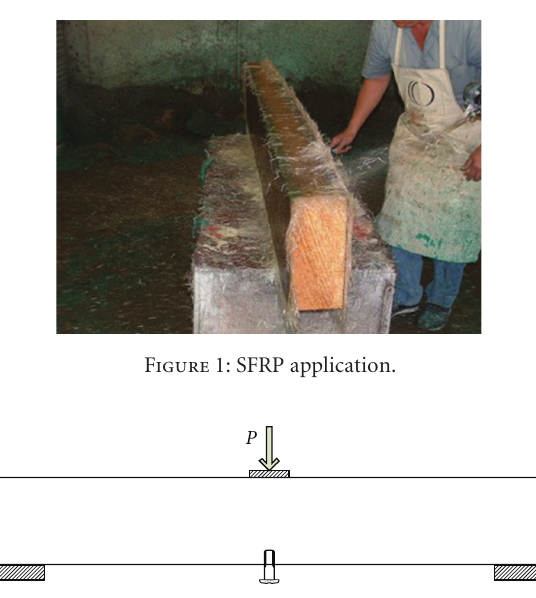
Figure 2: Beam dimensions and instrumentation diagram.